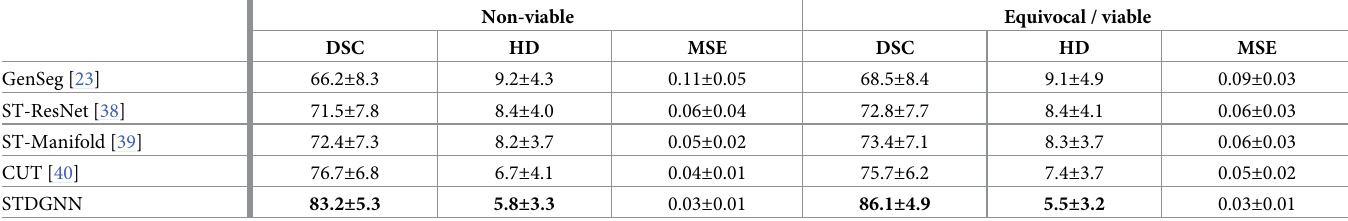
Table 2. Comparison with predictive methods. DSC: Dice score coefficient of HCC segmentation, HD: Hausdorff distance (mm) of HCC segmentation, MSE: Mean squared error in voxel intensities of the predicted images. Analysis of differences was performed by paired Wilcoxon tests ( p < 0.05). Bold values indicate significant